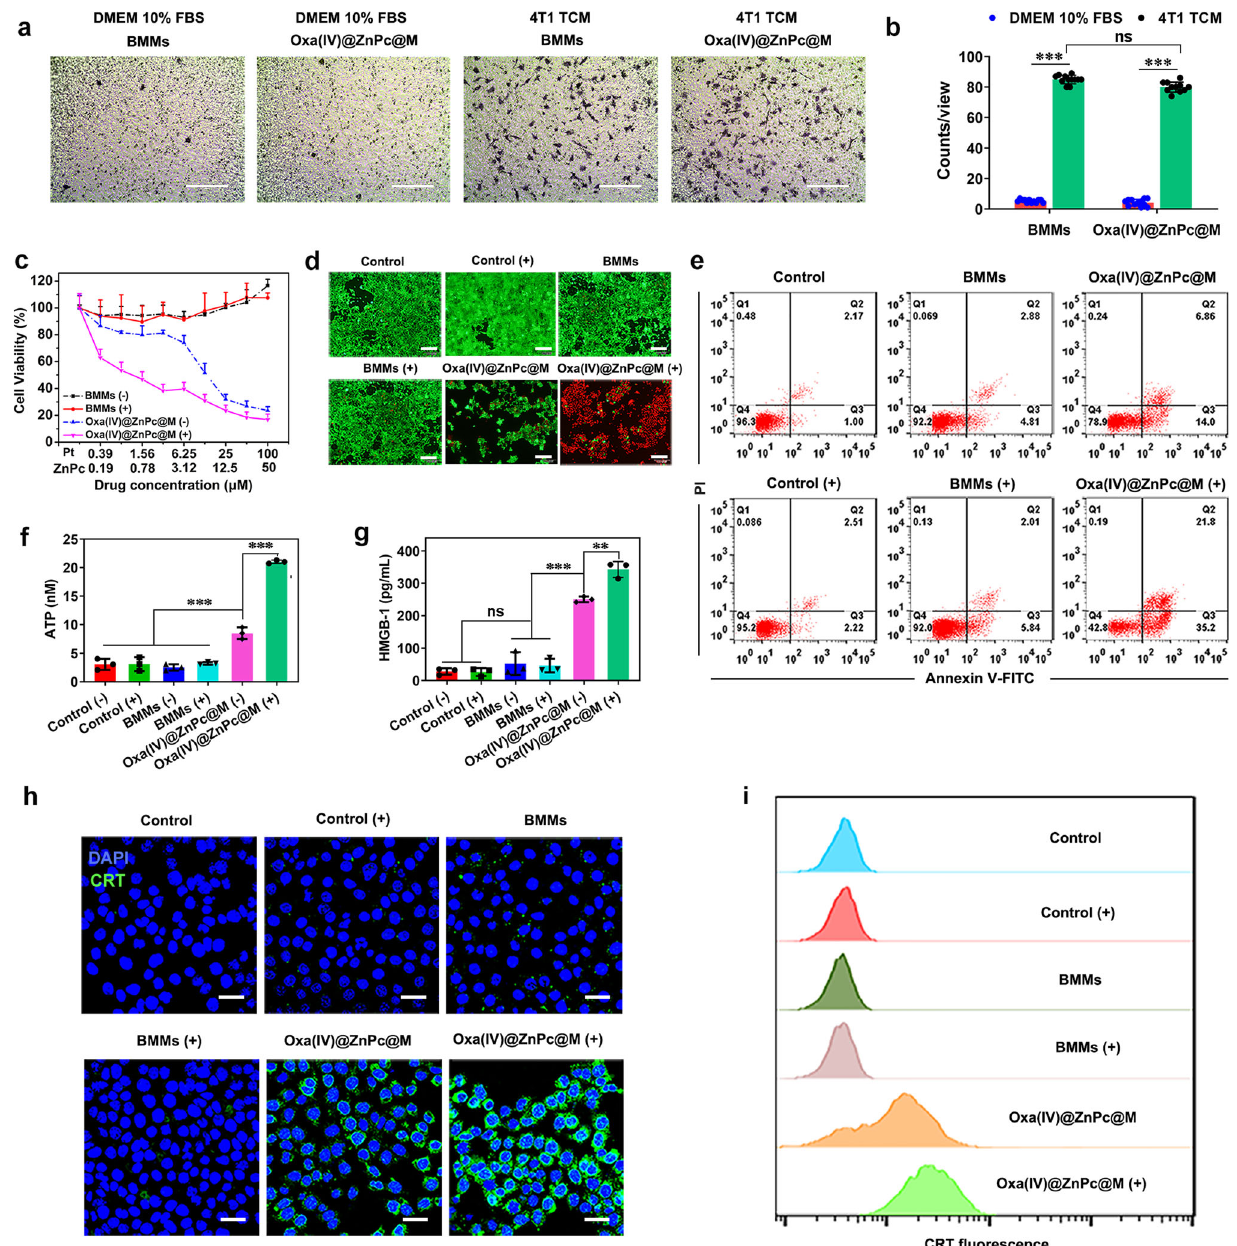
Fig. 3 The tumor tropism, cell killing, and ICD induction ability of Oxa(IV)@ZnPc@M in vitro. a Optical microscopy images of migratory BMMs or Oxa (IV)@ZnPc@M stained by crystal violet using a transwell system with cell growth medium (DMEM 10% FBS) or 4T1 TCM added in the bottom chamber. Scale bars = 200 µ m. b Quantitative evaluation of migratory cells per representative view ( n = 12 technical replicates, *** p < 0.0001), the experiment is representative of three independent experiments. c Cell viability ( n = 3 technical replicates, the experiment is representative of three independent experiments) and d live/dead cell staining assay of 4T1 cells after treatment by BMMs and Oxa(IV)@ZnPc@M with or without light irradiation, this experiment was performed two times with similar results. Scale bars = 200 µ m. e Quantitative apoptosis analysis of 4T1 cells stained with Annexin V- FITC/PI. Quantitative determination of f ATP secretion (*** p < 0.0001, *** p < 0.0001) and g HMGB-1 release of 4T1 cells after various treatment ( n = 3 technical replicates, the experiment is representative of three independent experiments, *** p < 0.0001, ** p = 0.0017). h CLSM images (this experiment was performed two times with similar results) and i Flow cytometric examination of CRT exposure on the surface of 4T1 cells (the experiment is representative of three independent experiments). Scale bars = 30 µ m. All data were presented as mean ± SD. Statistical signi fi cance was calculated via the unpaired two-tailed t test b or ordinary one-way ANOVA with a Tukey ’ s test f , g . “ ns ” represents not signi fi cant, and * p < 0.05, ** p < 0.01, *** p < 0.001. Source data are provided as a Source data fi